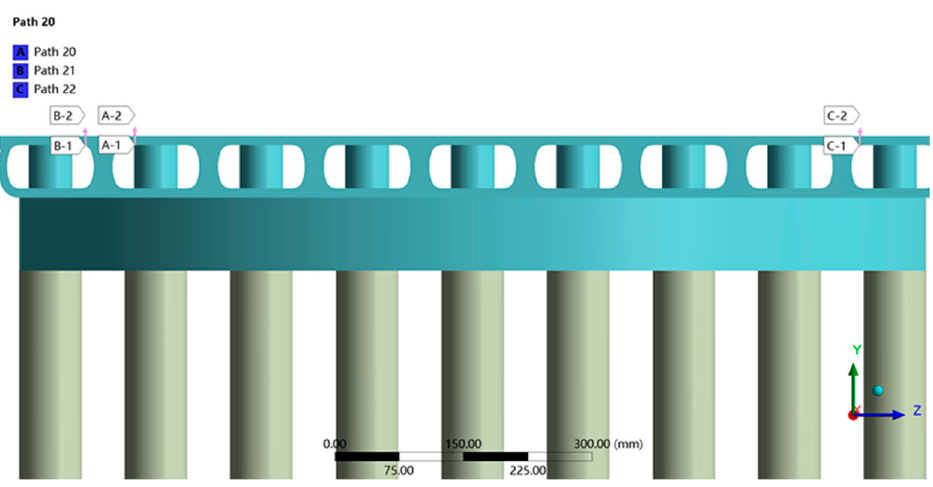
Figure 9. Paths for stress linearization on the flat-round tubesheet.